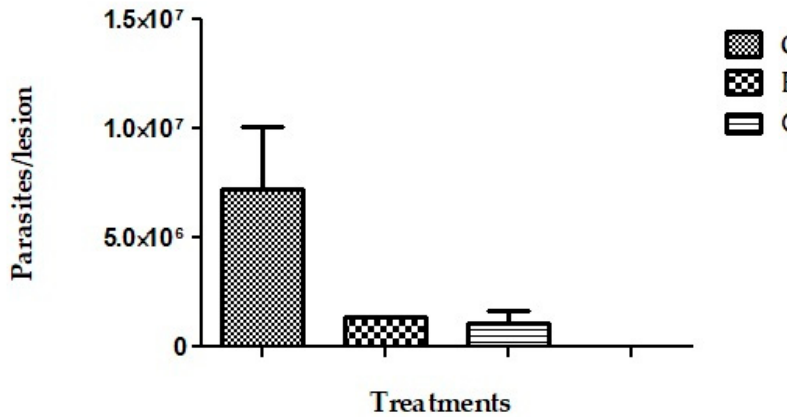
Figure 4. E ffi cacy of topical treatment with 15% EGCG in BALB / c mice infected with L. (L.) amazonensis . Parasite burden decreased significantly after 18 days of treatment with topical EGCG with respect to control group ( p < 0.05). In addition, EGCG showed a similar e ffi cacy to the intraperitoneal Gl treatment. Results represent the mean ± standard deviation of two independent experiments.